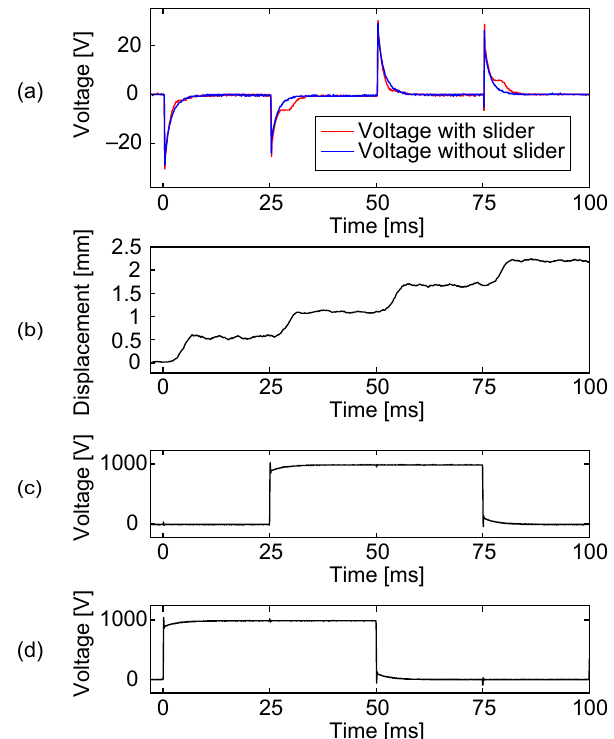
Figure 14. The voltage of the sensing electrode during slider motion when the resistance switch was not utilized. The sensing electrode was directly connected to an oscilloscope via a 100:1 passive probe. Plot ( a ) shows the sensing electrode voltage in red. For comparison, the sensing electrode voltage was measured without a slider (blue). Plot ( b ) shows slider motion. Ideally, the slider should move 0.6 mm at every voltage shift, but the actual step length was found to be slightly smaller for this particular case. Plots ( c , d ) are two voltages out of four applied to the stator